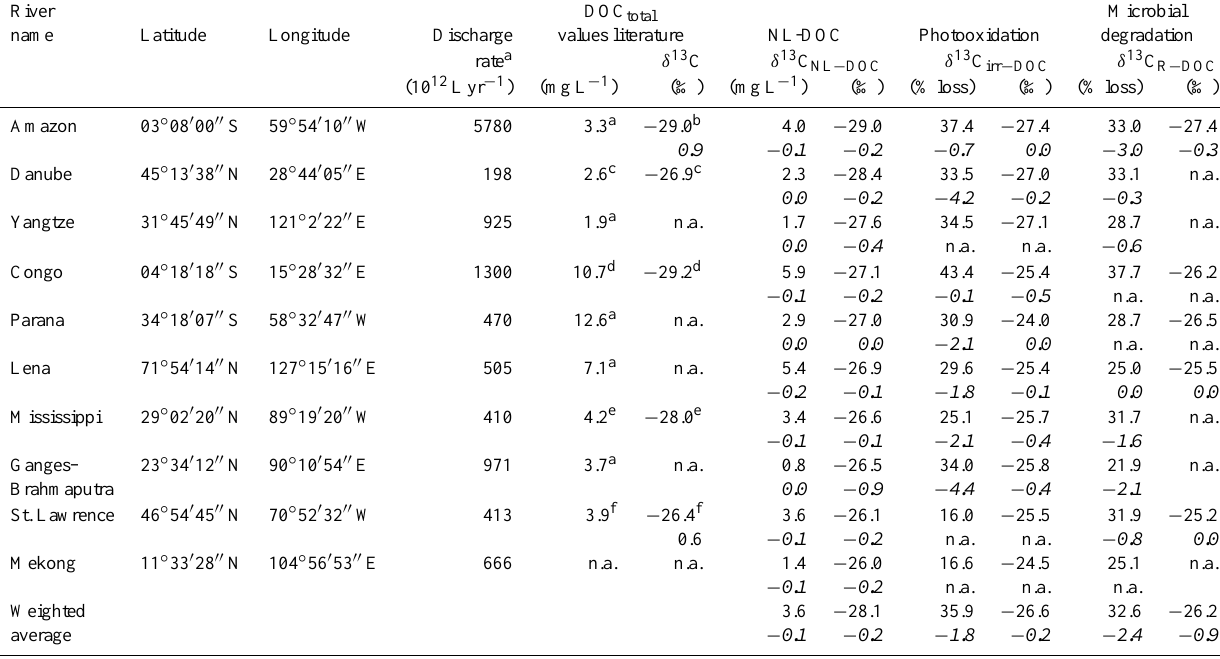
Table 1. The sampling locations of rivers, discharge rates, the concentration of non-labile DOC (NL-DOC) and its δ 13 C signature at the beginning of experiment, the loss of NL-DOC (%) in 10-day-long irradiation (Photooxidation) and following 28-day bioassay (Microbial degradation) with associated δ 13 C signature in the residual DOC after the treatments. Literature DOC concentrations and δ 13 C signature are also given; sampling locations of literature values are not identical to sampling locations in this study. Standard deviations of duplicated ( n = 3) determinations are given under the reported δ 13 C values in italics. The weighted averages were calculated by normalizing NL-DOC and δ 13 C with discharge rates. Details can be found in the indicated references: a Cauwet (2002), b Mayorga et al. (2005), c Saliot et al. (2002), d Spencer et al. (2009), e Wang et al. (2004), and f Hélie and Hillaire-Marcel